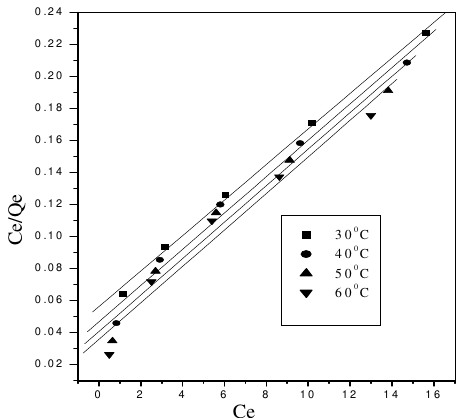
Figure 2 . Effect of contact time on the removal of malachite green [M G] = 30 mg /L; adsorbent dose =25 mg/50 mL; temp = 30 o C